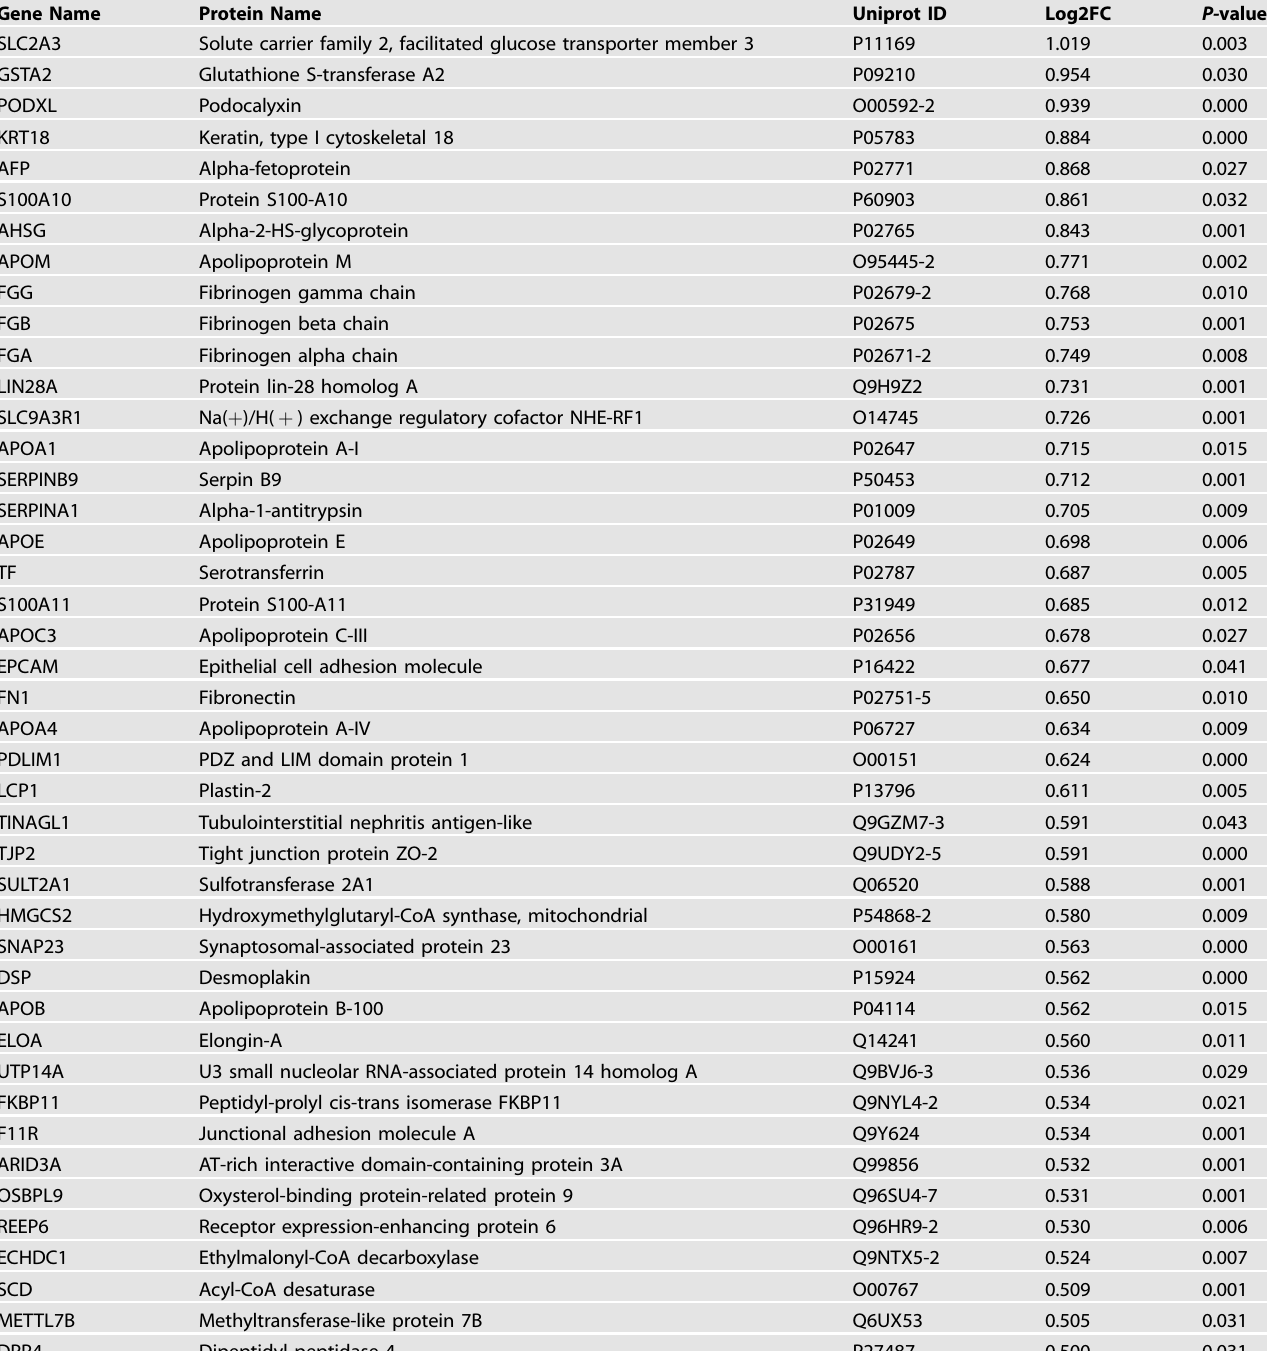
Table 2. 43 Up-regulated proteins in Scz organoids (>0.5 Log2FC, p <